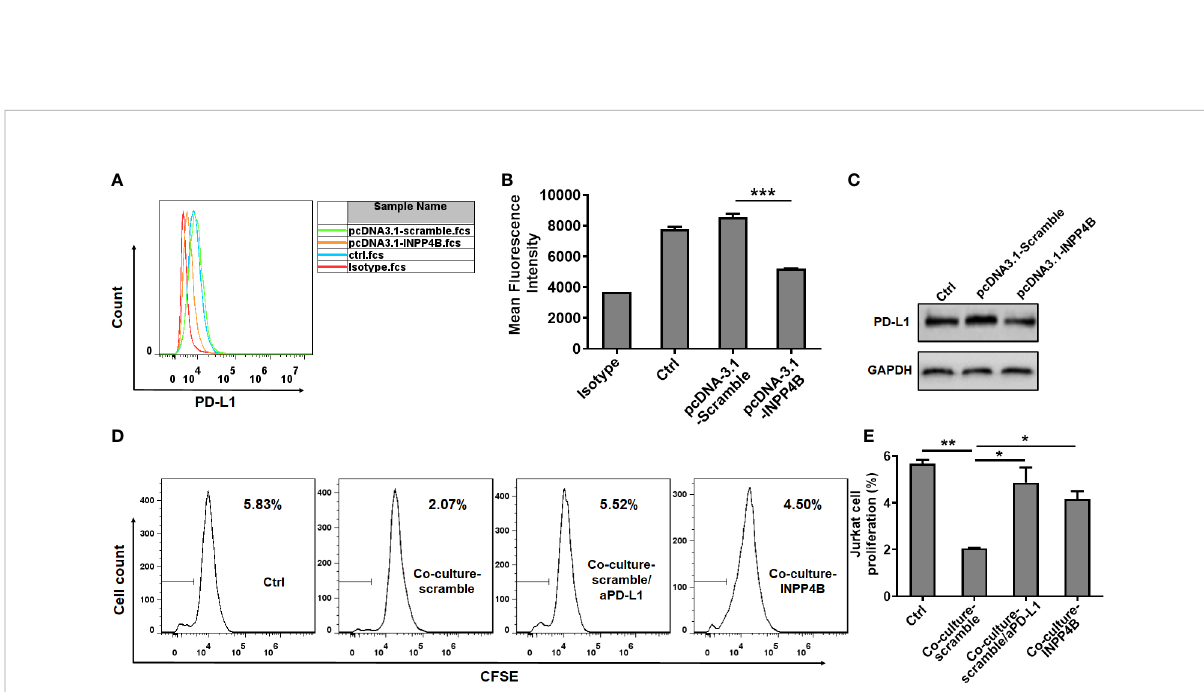
FIGURE 5 INPP4B overexpression reduces PD-L1 expression and T cell-suppression by glioma cells. U87 glioma cells transfected with scramble (pCDNA3.1-Scramble) or INPP4B-overexpressing (pCDNA3.1-INPP4B) vectors were assessed for PD-L1 expression by (A, B) fl ow cytometry or (C) western blot. (D, E) The proliferation of Jurkat cells was analyzed under four conditions (Jurkat cells alone, Jurkat cells co-cultured with U87 cells transfected with scramble [pCDNA3.1-Scramble], Jurkat cells co-cultured with U87 cells transfected with INPP4B-overexpressing [pCDNA3.1-INPP4B] vector, and Jurkat cells co-cultured with scramble-transfected U87 cells treated with anti-PD-L1 antibody [ a PD-L1]). The percentage of cells that had undergone division (discrete peaks corresponding to CFSE dilution: gates on the histogram plots) was measured by fl ow cytometry. Values represent the means ± SD (n = 3); * p < 0.05, ** p < 0.01, *** p <